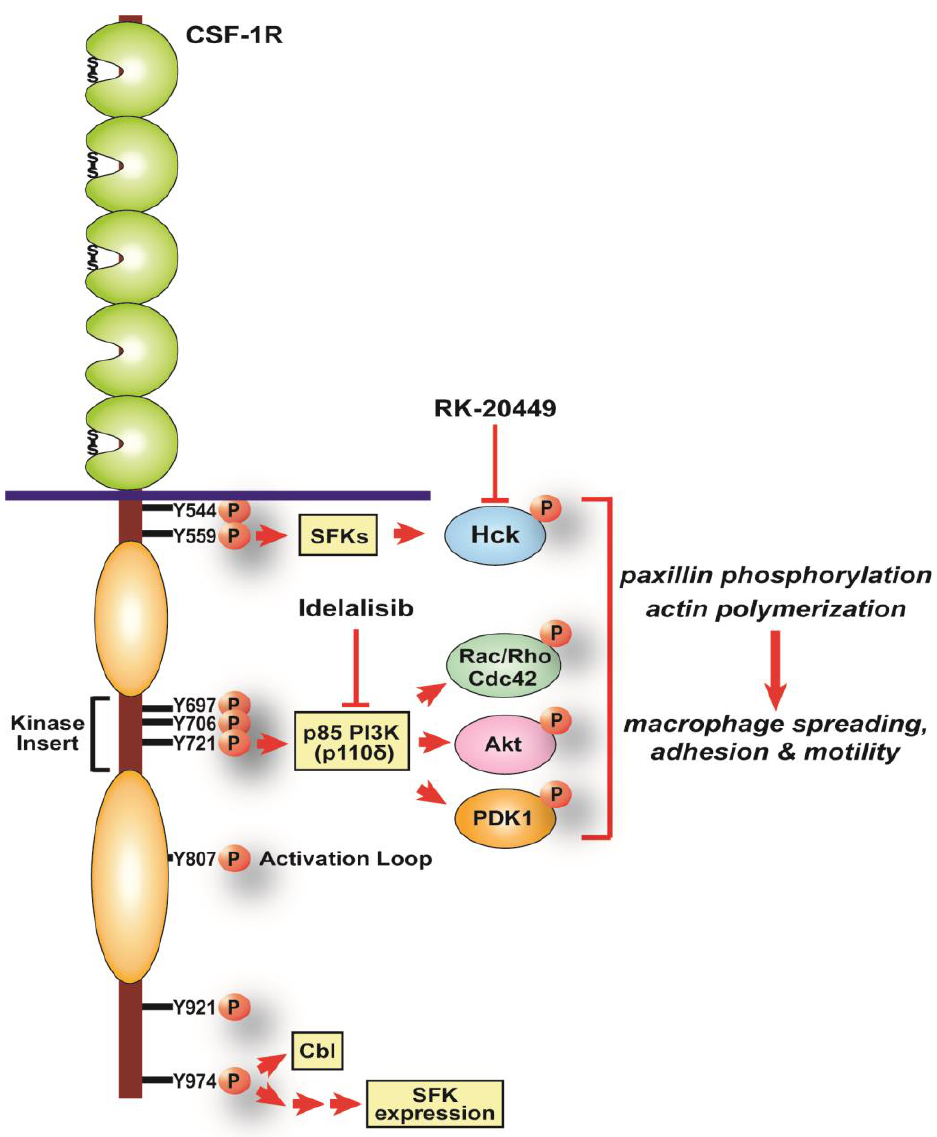
Figure 3. Schematic of the colony-stimulating factor-1 receptor (CSF-1R) and downstream motility signaling. Upon binding of CSF-1, the CSF-1R homo-dimerizes and autophosphorylates up to eight tyrosine residues. Both the pY721 and pY974 motifs have been shown to be important for motility signaling. pY721 directly stimulates macrophage motility through activation of PI3K p110δ, leading